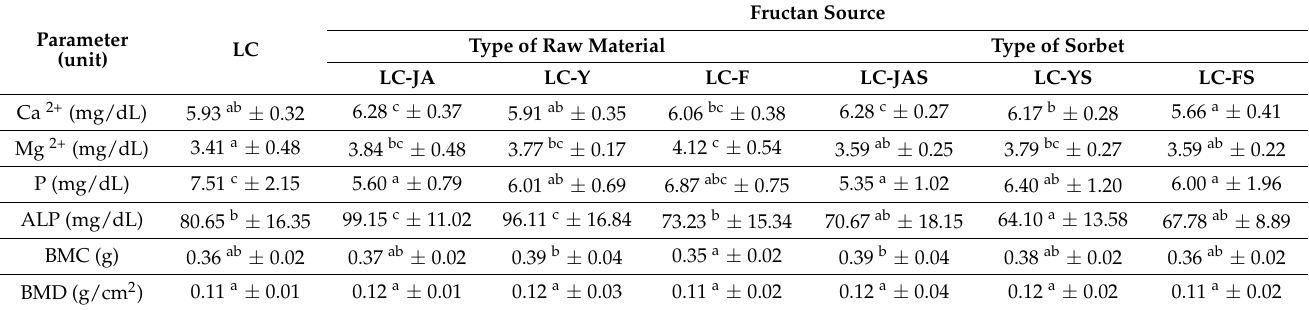
Table 3. Effects of different fructan sources added to the diet (alone or as components of sorbet) on selected parameters of mineral metabolism in growing rats after 12 weeks of